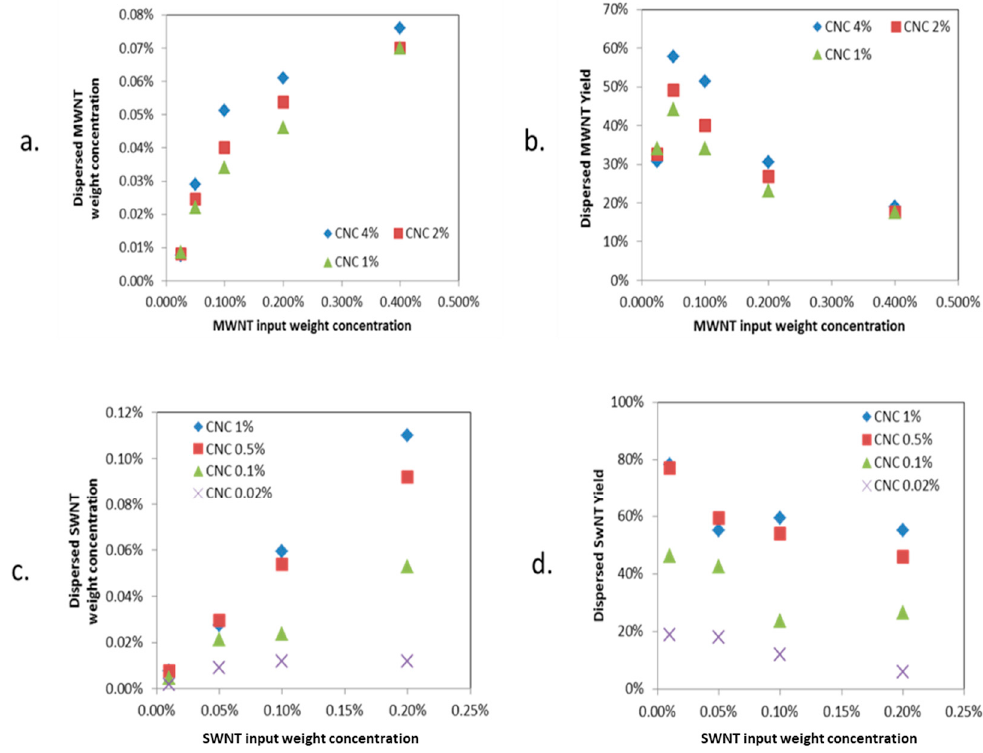
Figure 2. MWNT ( a , b ) and SWNT ( c , d ) dispersed concentration and yield vs. initial added CNT concentration with different CNC concentrations.